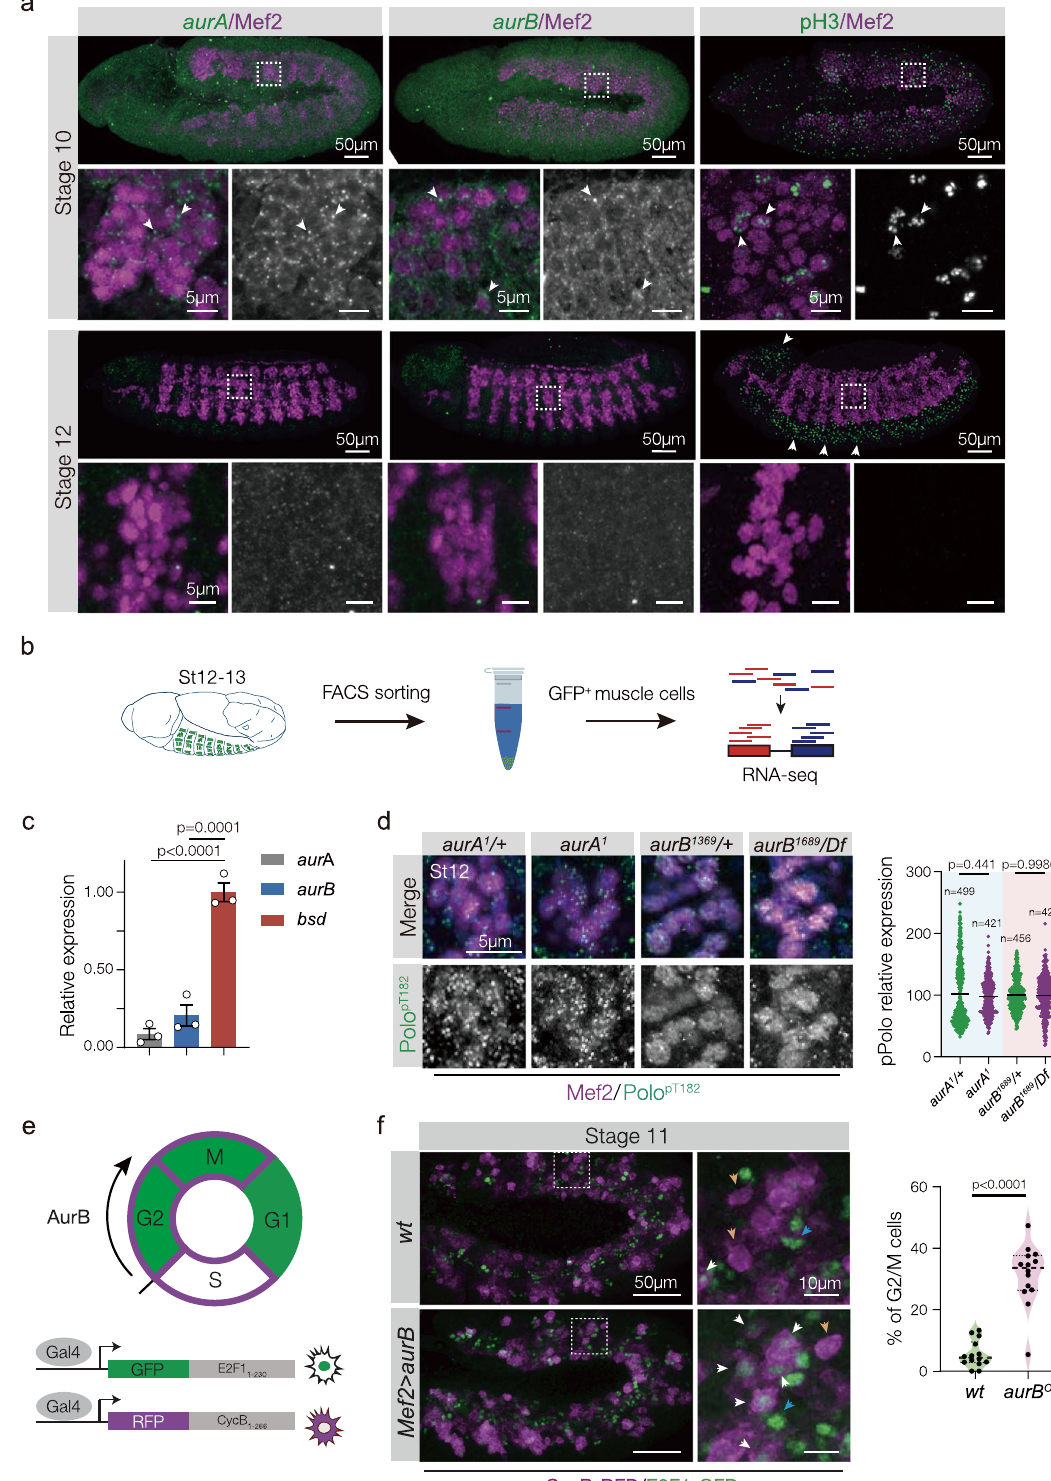
direct myotube guidance remains unclear, but Tum and Pav appear to function outside of the nucleus to direct changes to the microtubule cytoskeleton in post-mitotic cells 27 . One possibility is that Bsd-activated Polo translocates to the myonucleus to